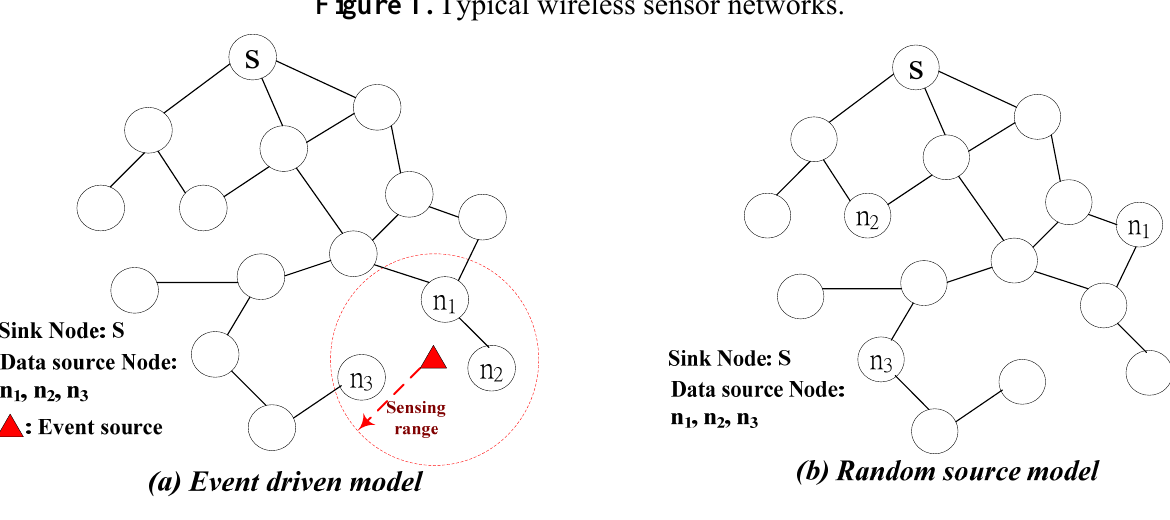
Figure 1. Typical wireless sensor